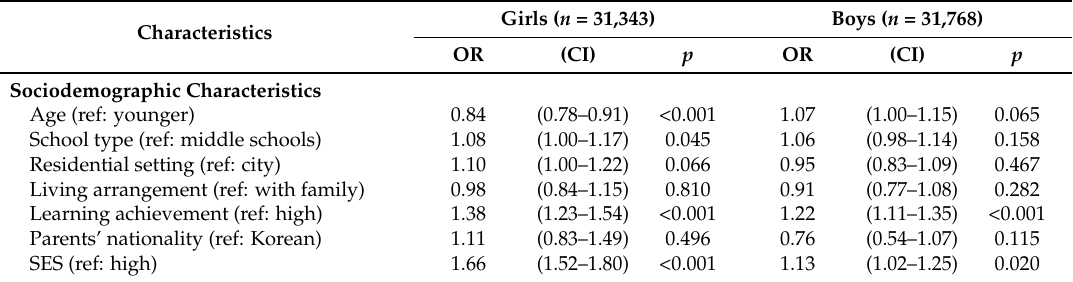
Crude associations of sociodemographic and behavioral characteristics with overweight/obesity among adolescents ( n = 63,111), wn = 3,272,722.